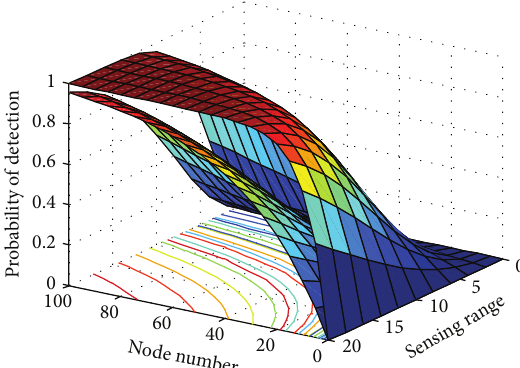
Figure 4: Intrusion detection probability that there is at least one node which detects an intruder, as a function of node number 𝑁